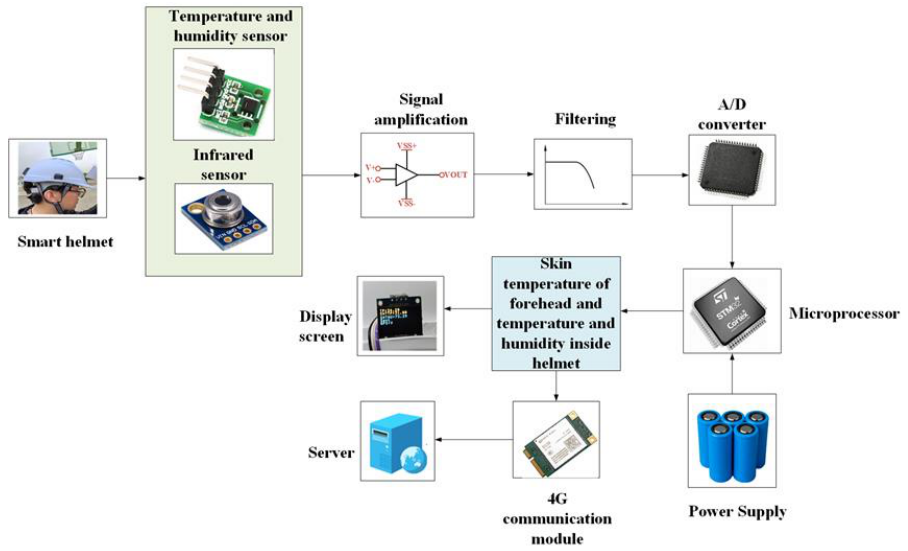
Figure 2. The smart helmet measurement